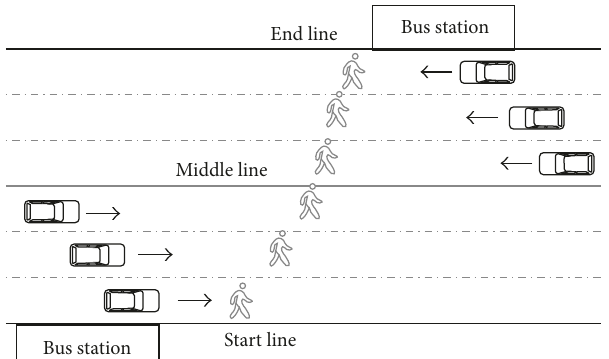
Figure 10: Schematic diagram of studied